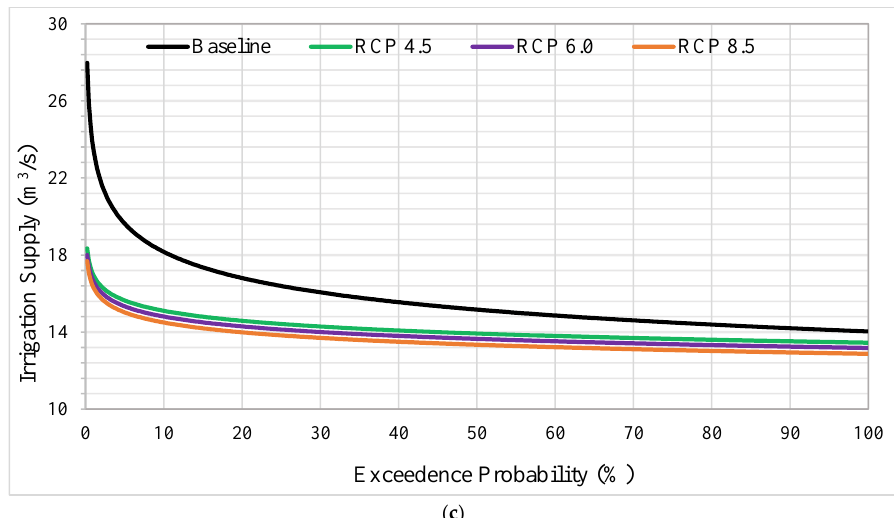
Figure 11. Flow duration curve for ensemble irrigation supply under RCPs with respect to baseline period of 1976–2005: ( a ) 2020s, ( b ) 2050s, and ( c ) 2080s.